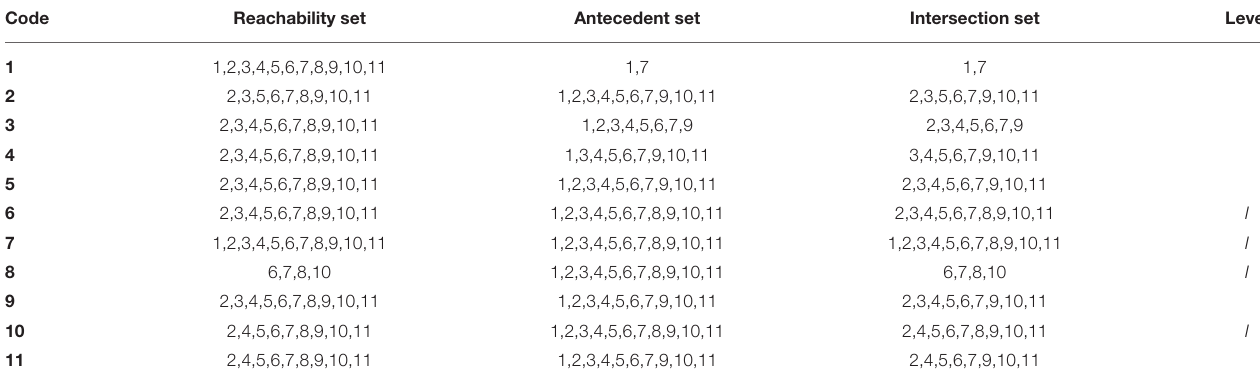
TABLE 6 | Iteration I.